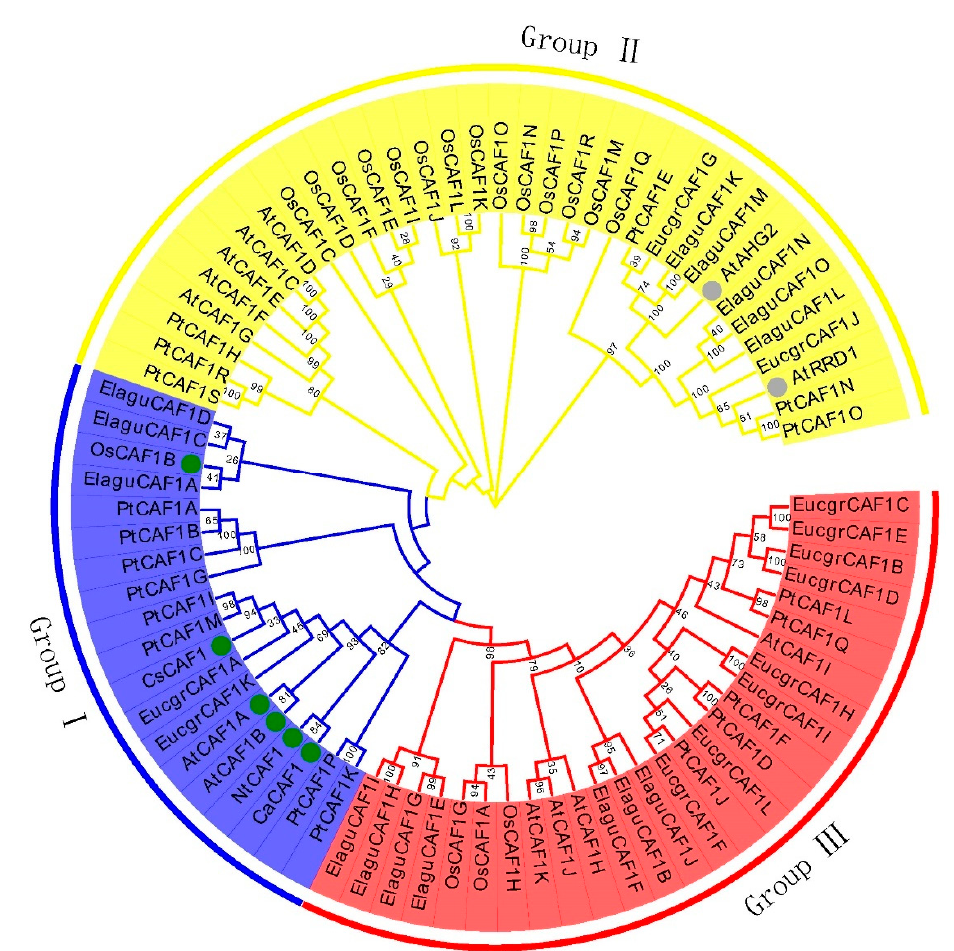
Figure 1. Phylogenetic relationship between P. trichocarpa and other plant species. Phylogenetic analyses of the PtCAF1 protein alignments of CAF1 domains among Oryza sativa , Arabidopsis thaliana , Eucalyptus grandis , Elaeis guineensis , Capsicum annuum , Citrus sinensis , and Nicotiana tabacum were performed with ClustalX2.1, and the phylogenetic tree was constructed using the NJ method with MEGA 7.0. The circle represents the gene whose function has been studied. The blue color denotes Group I, the yellow color denotes Group II, and the red color denotes Group